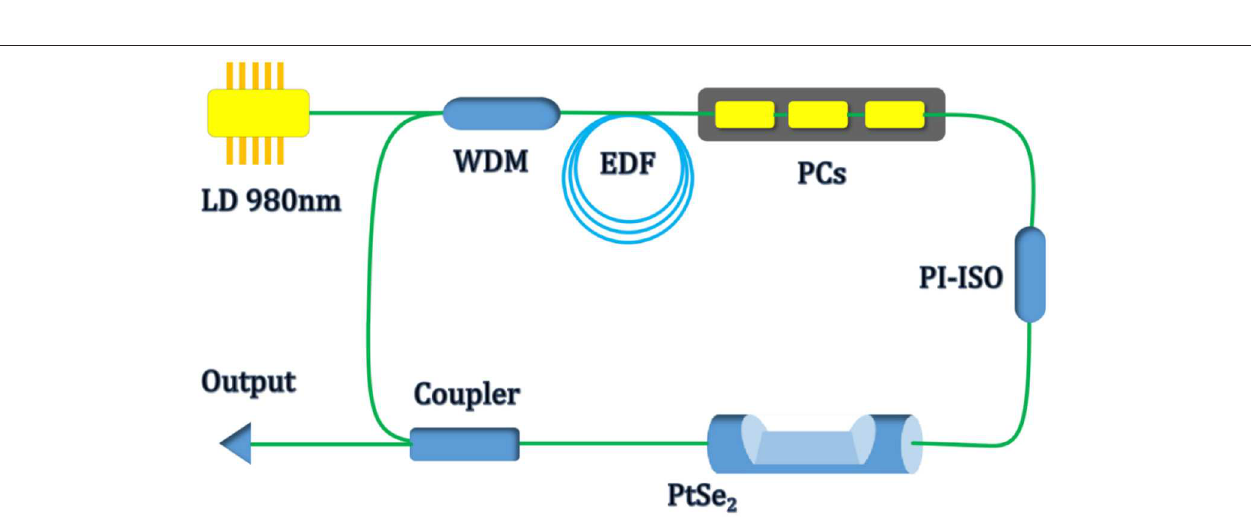
FIGURE 1 | (A) Raman spectrum of PtSe 2 (The inset is the SEM of PtSe 2 ). (B) The non-linear optical absorption curve of PtSe 2 .